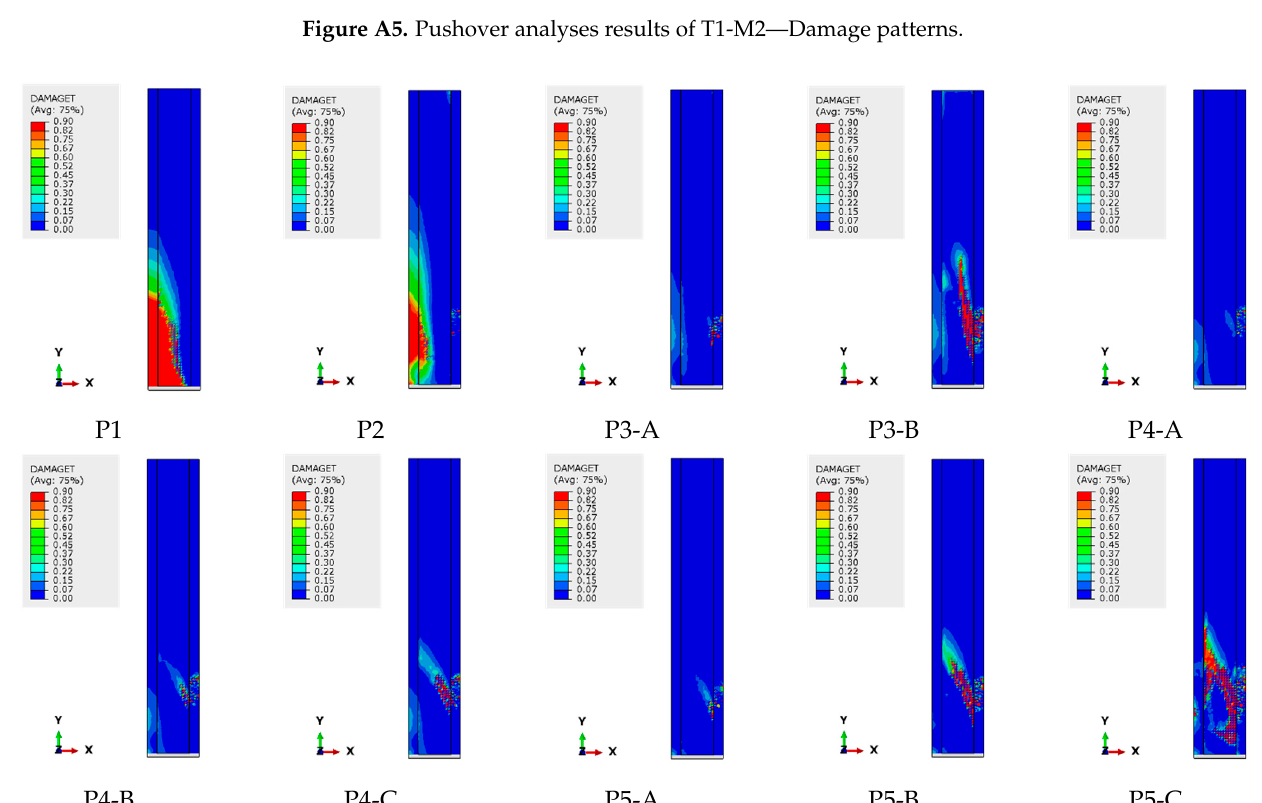
Figure B3. Pushover analyses results of T1-M3—Damage patterns.